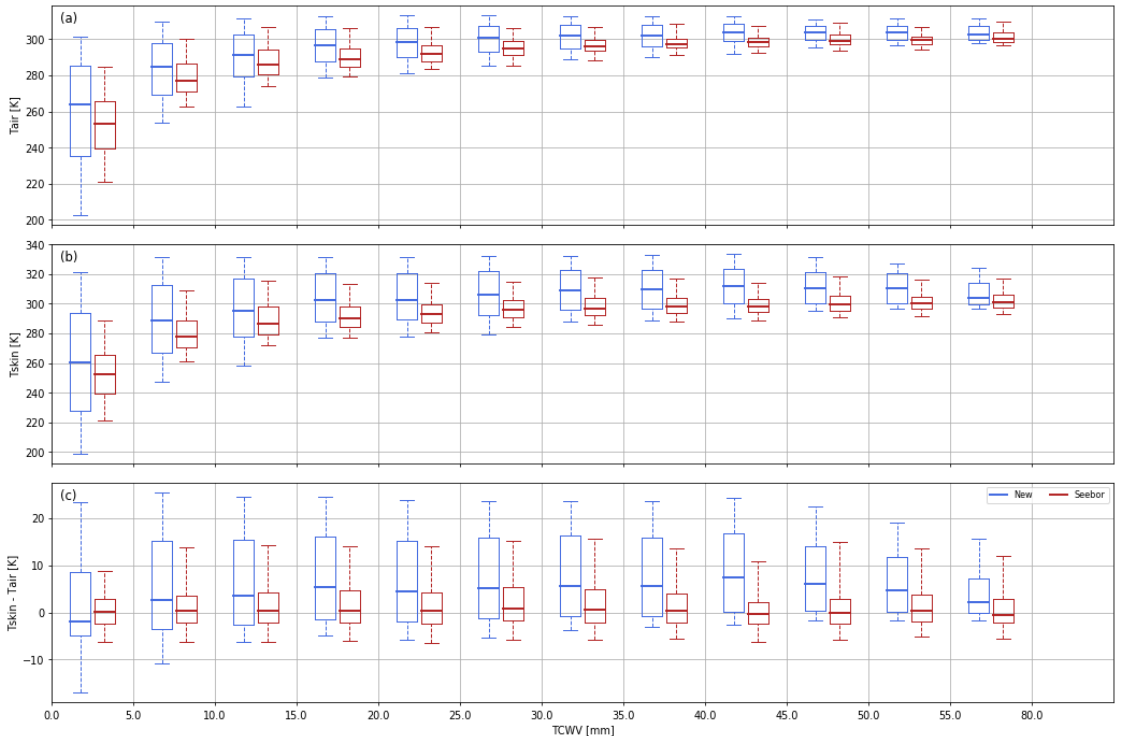
Figure 5. Distribution of the ( a ) surface air temperature (Tair), ( b ) skin temperature (Tskin), and ( c ) the difference between skin and surface air temperatures for each TCWV class. The bold line represents the median, the box represents the 25th to 75th percentiles, and the whiskers represent the 5th and 95th percentiles. Values are shown for the new calibration database (blues) and the SeeBor database (red).